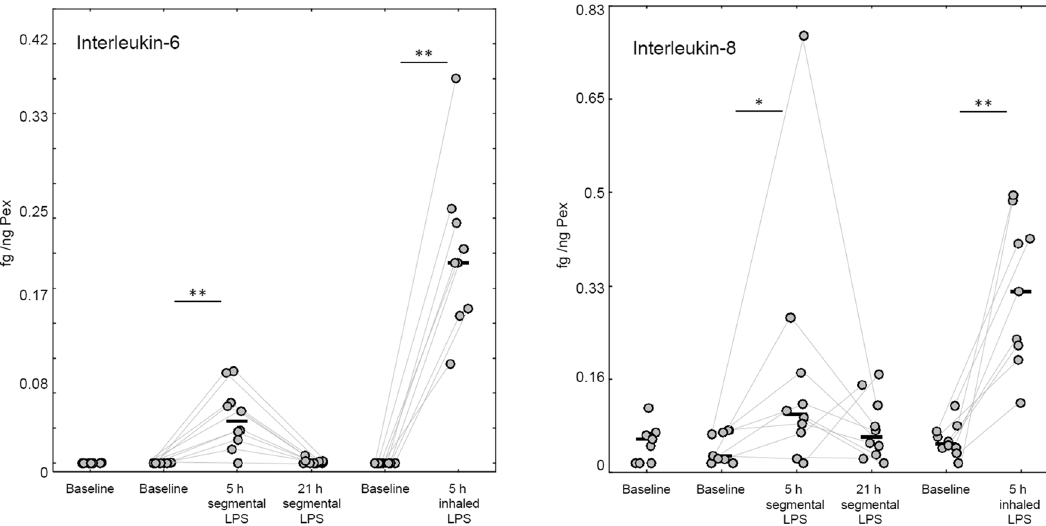
Figure 2. Individual and median concentrations of interleukin-6 and interleukin-8 per ng PEx. Two hundred microliters of elution buffer was used for a membrane with 120 ng of exhaled breath particles (PEx).*p < 0.05,**p < 0.01, Wilcoxon-matched